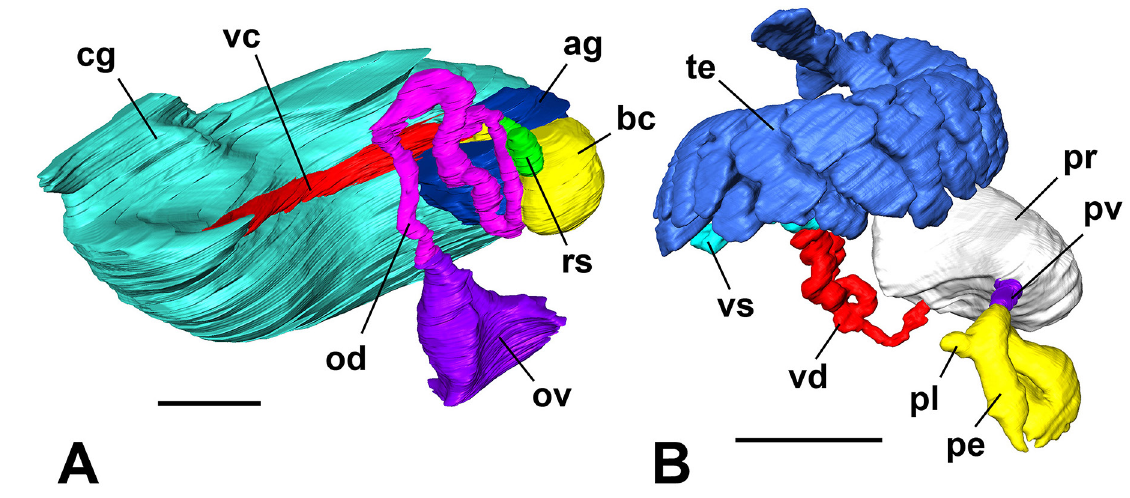
Fig. 13. Genitalia of Opacuincola m. kahurangi subsp. nov. µCT scans. A . ♀. B . ♂. Abbreviations: ag = albumen gland; bc = bursa copulatrix; cg = capsule gland; od = oviduct; ov = ovary; pe = penis; pl = penial lobe; pr = prostate; pv = pallial vas deferens; rs = receptaculum seminis; te = testis; vc = ventral channel; vd = vas deferens; vs = vesicula seminalis. Scale bars = 100